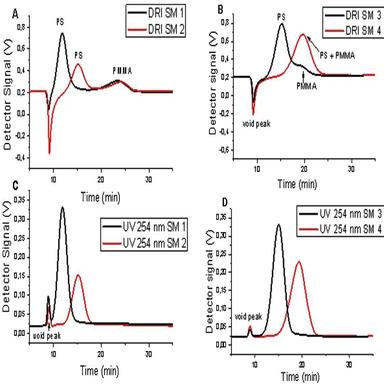
ThFFF fractograms for PS and PMMA blends SM1, SM2, SM3, and SM4. A and B; the sample blends detected by dRI. C and D; the sample blends detected by UV. Experimental ThFFF conditions: flow-rate = 0.30 mL/min, dT = 60K.